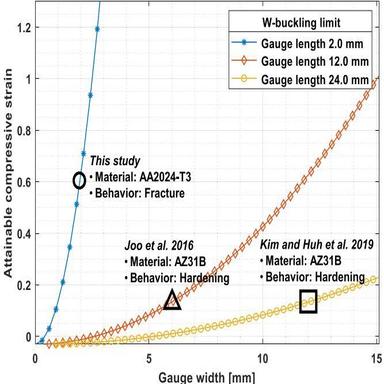
Attainable compressive strain without W-buckling proposed by.